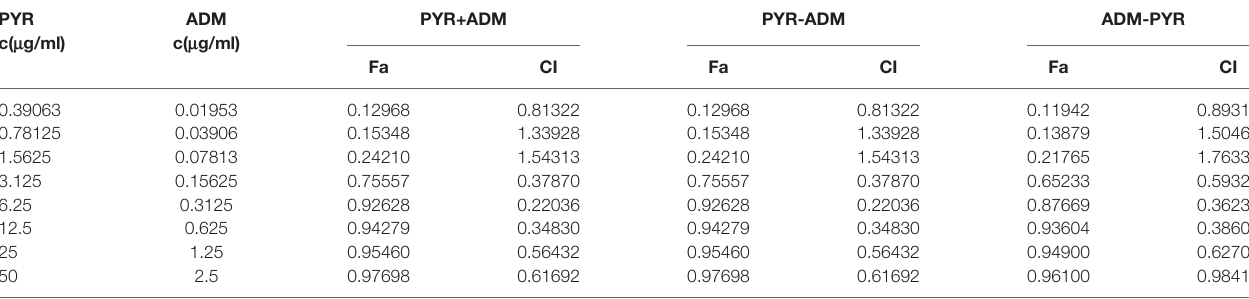
TABLE 1 | Combination Index Value and Fraction Affected of PYR and ADM on AU565 cells.